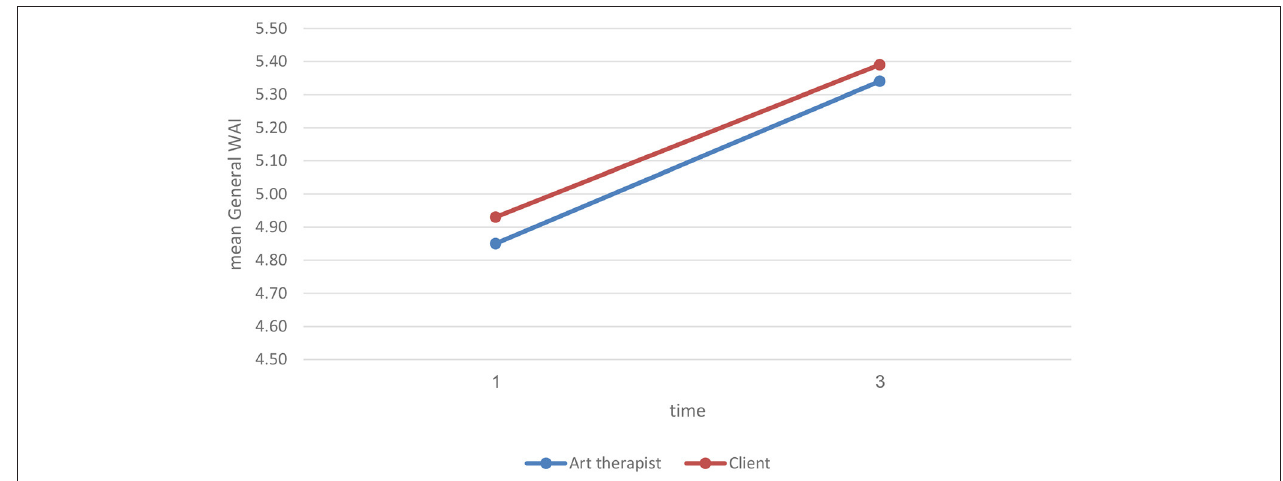
FIGURE 1 | General WAI scores at T1 and